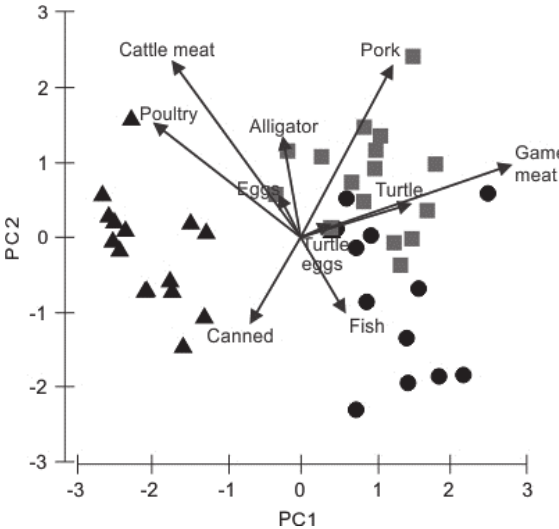
Figure 2 - Distribution of the first two main components according to the consumption of different food items by the three studied populations (Trombetas: squares; Purus: circles; Amazon: